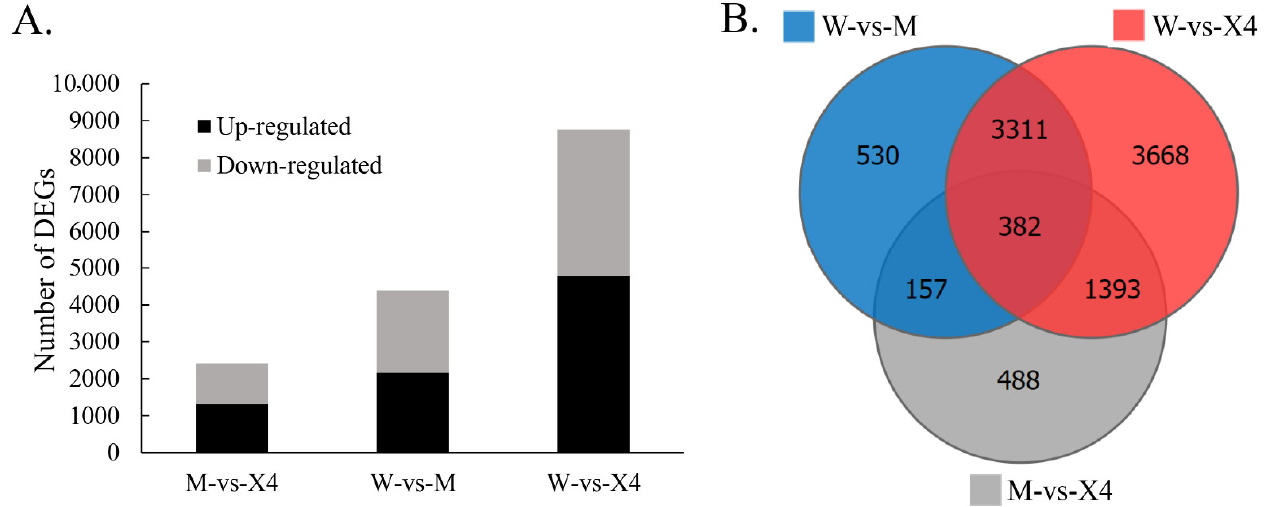
Figure 3. Differential gene expression in pecan fruits in the presence of FBS in resistant/susceptible cultivars. ( A ) Number of upregulated and downregulated DEGs (|log2Fold change| ≥ 1 and p -value < 0.05). ( B ) Quantity statistics Venn diagram of DEGs among three sampling groups (|log2Fold change| ≥ 1 and p -value <